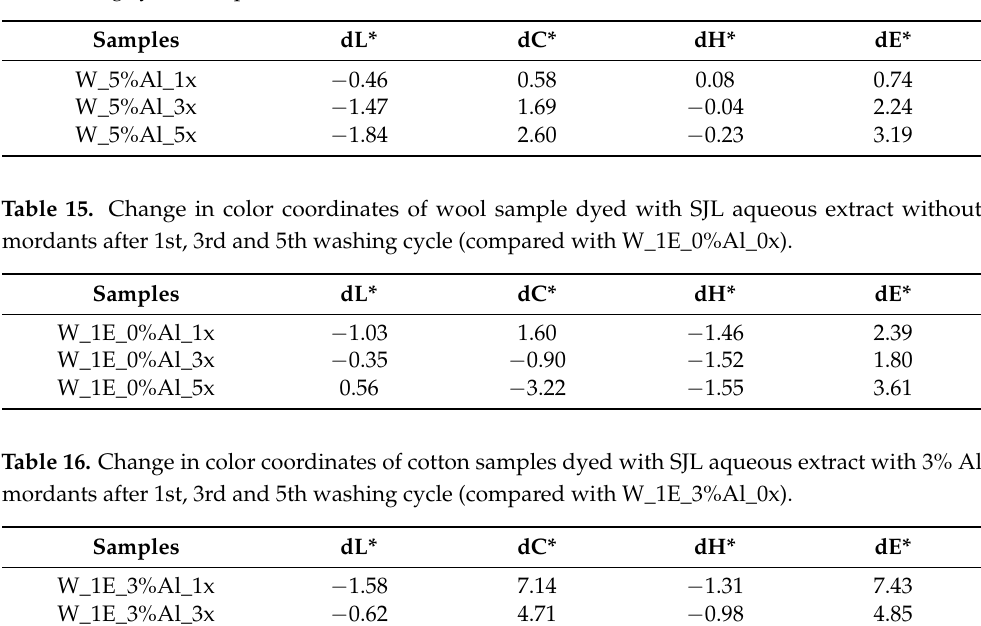
Table 14. Change in color coordinates of wool sample treated with 5% Al mordants after 1st, 3rd and 5th washing cycle (compared with W_5%Al_0x).